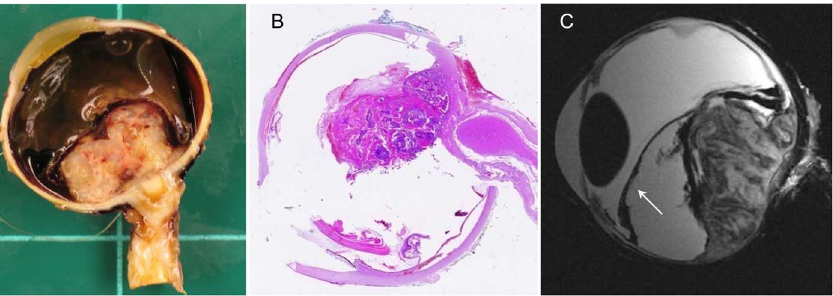
Figure 4. Intraocular metastasis of esophageal cancer with choroidal and retinal detachment (arrow). A – Enucleated eye with optic nerve segment. B – H&E stain, overview: A large, cloudy, solid tumor with retinal and choroidal detachment is apparent around the optic disc. C – Sagittal T2w image: Heterogeneous signal intensity reflecting the heterogeneous ultrastructure of the tumor with low-signal-intensity foci corresponding to intratumoral hemorrhage.